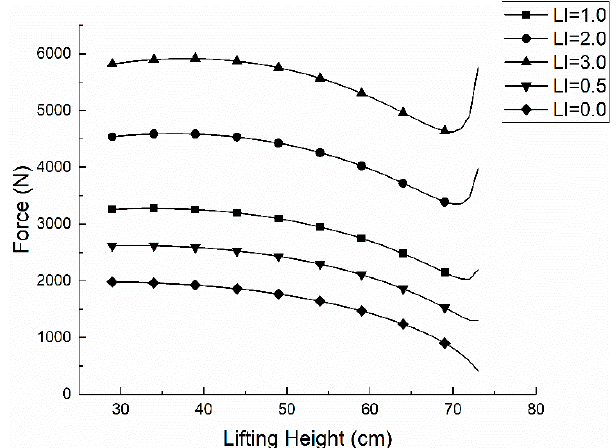
Figure 3. The relationship between F and h .